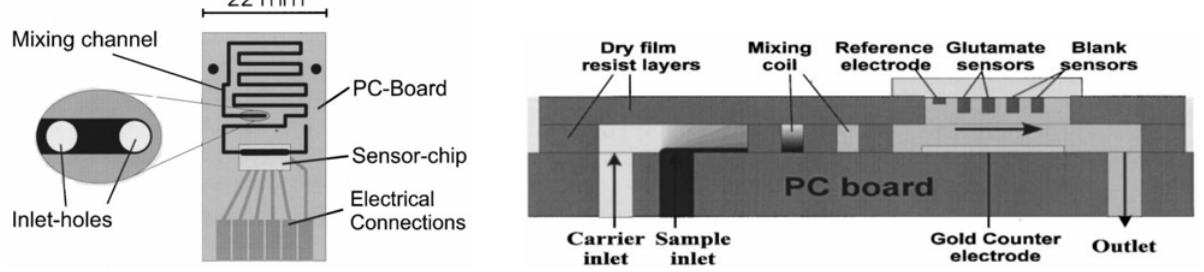
Figure 10. ( Left ) Schematic top view of the microsystem. ( Right ) Schematic cross section of the integrated device